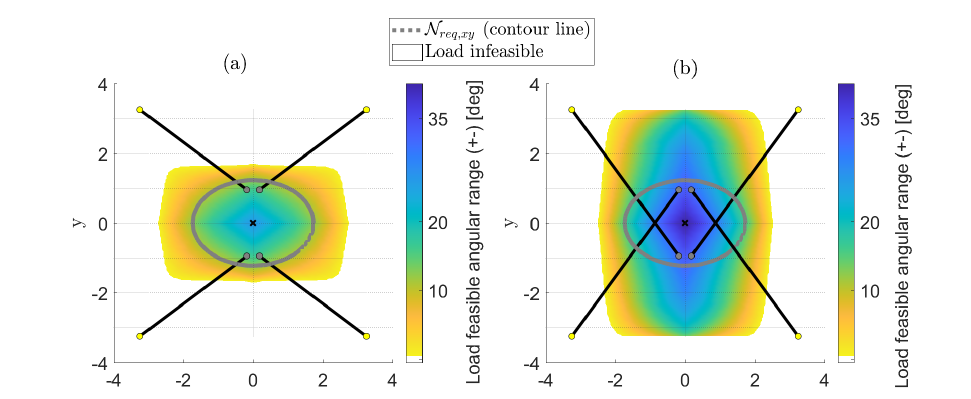
Figure 11. Visual representation of the wrench feasible workspace N for the two actuator configura- tions of Table 2. The black lines represent cables configuration at η of wrench feasibility as a function of ψ (in degrees). For example, if the colour of a cell indicates a value of 20, it is wrench feasible with − 20 < ψ < 20 [ deg ] . ( a ) Actuator configuration 1 (uncrossed). ( b ) Actuator configuration 2 (crossed).